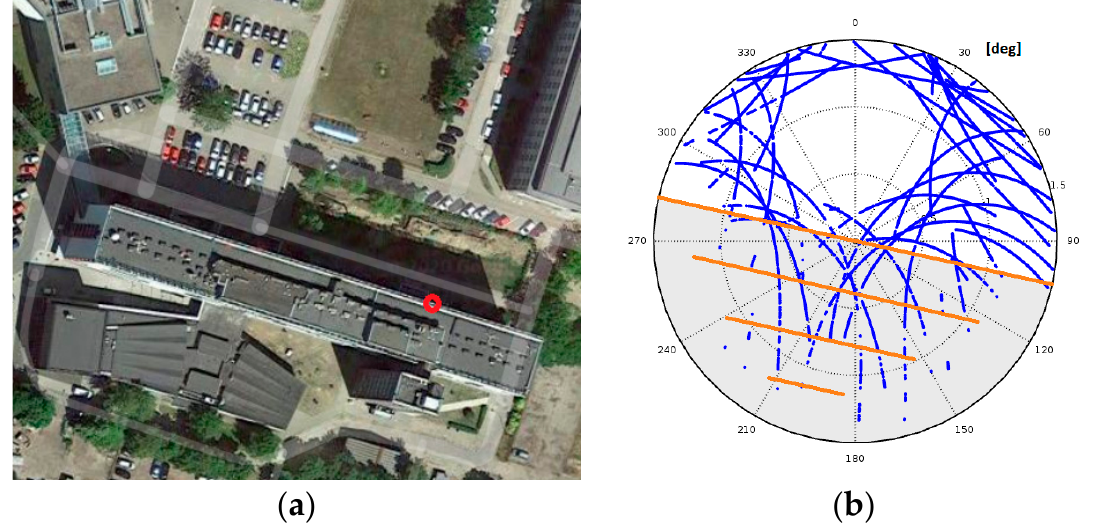
Figure 5. Example of GNSS constellation for an obscured sky view (polar map) ( b ) for survey position ( a ).